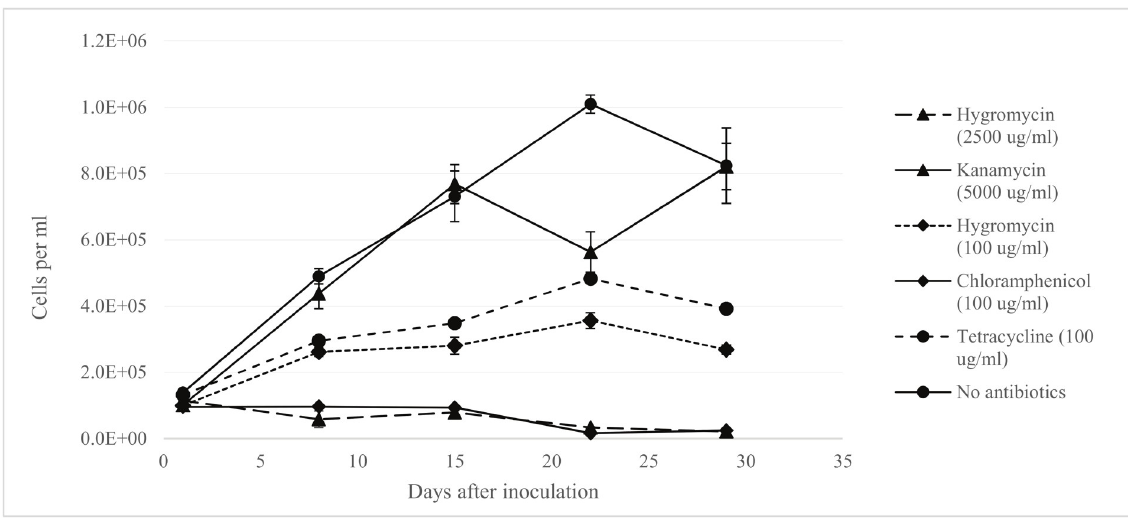
Fig 1. Growth of Symbiodinium CCMP2467 in f/2 liquid medium under antibiotic selection. Results of Symbiodinium growth were from three biological replicates, each measured four times using a FlowCAM. The error bars indicate standard error of the mean (S16 File).